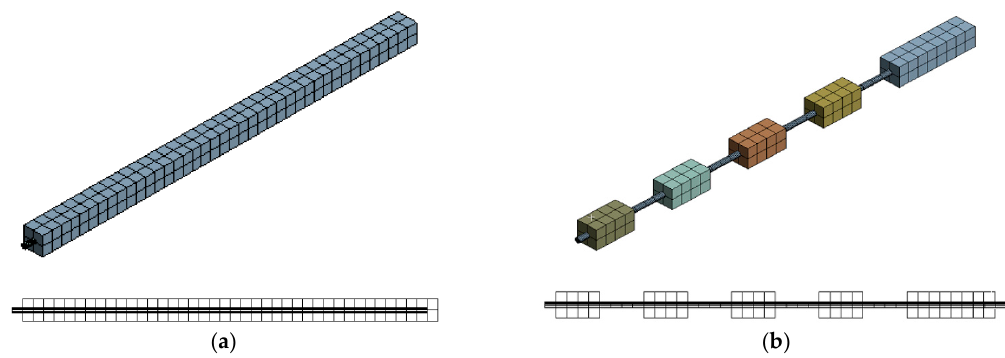
Figure 12. Discretization of numerical models: ( a ) S100_1 and ( b ) S60_7.